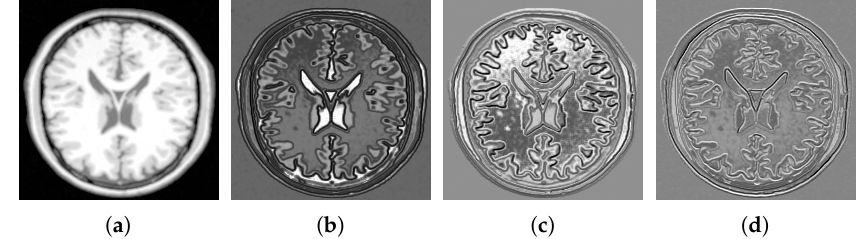
Figure 6. Structural representation of T1-MRI using Laplacian Eigenmap. Feature images indexed 1, 6, 11, and 18 are shown in ( a – d ), respectively. Algorithm 1: Summary of dimensionality reduction (structural representation) with Laplacian